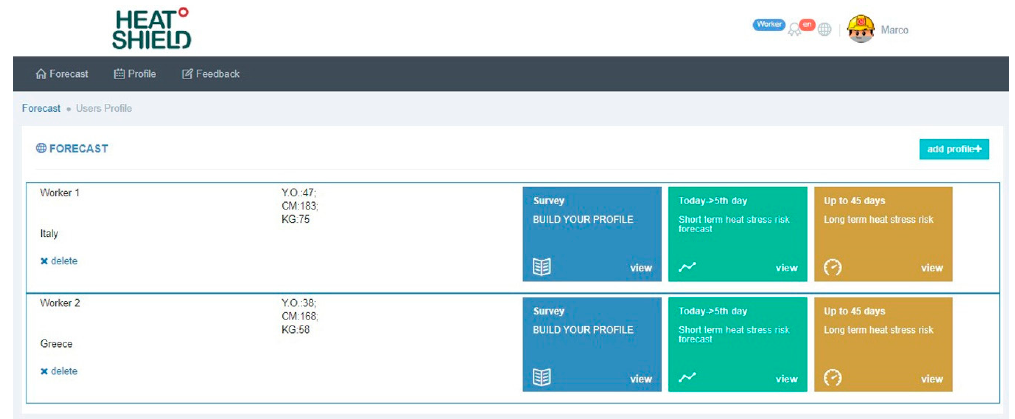
Figure 7. Worker’s heat stress risk in the long term (from the 6th to the 46th day forecasted) available in the own profile of the personalized heat stress warning.